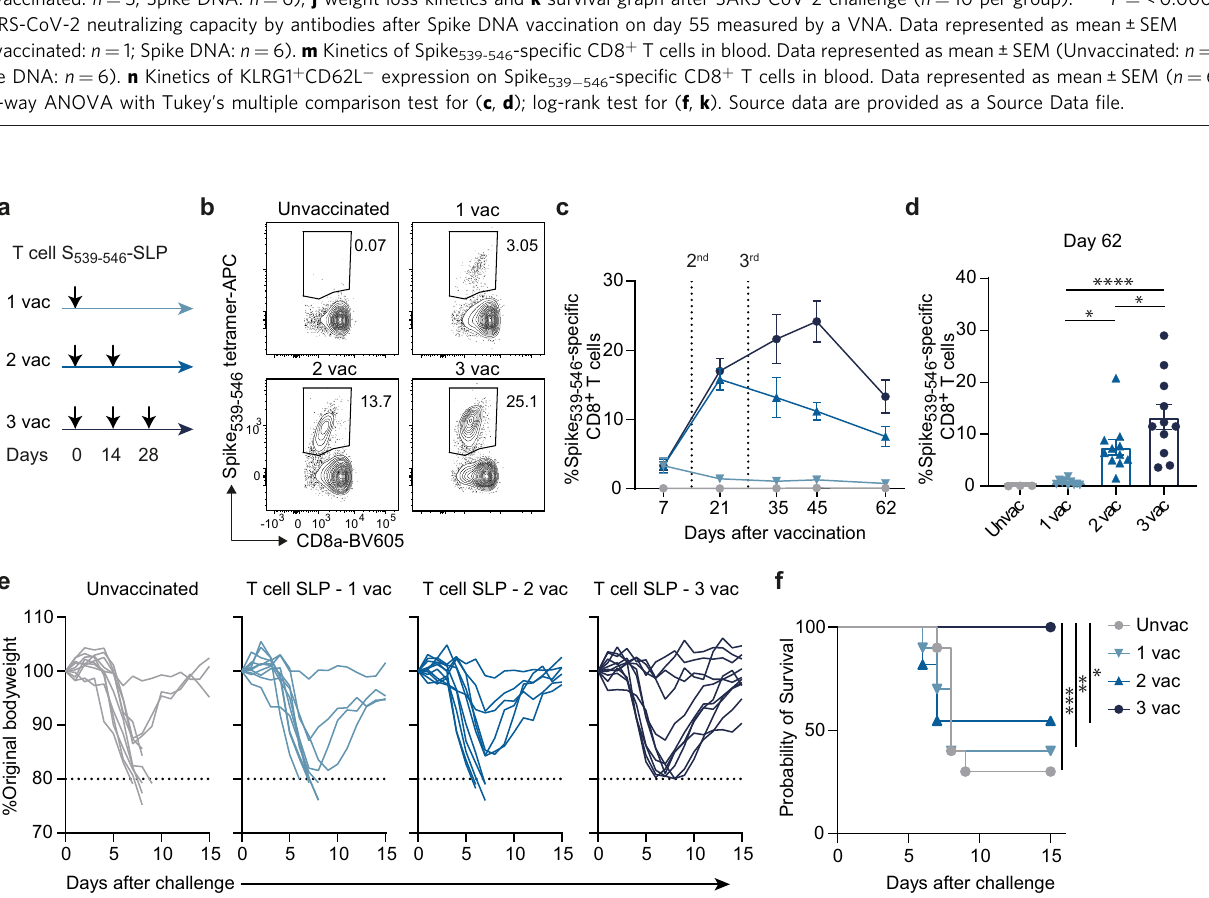
Fig. 2 A third vaccination with a single T cell epitope protects against SARS-CoV-2 challenge. a K18-hACE2 transgenic mice were vaccinated subcutaneously on day 0 (1 st vaccination), day 14 (2 nd vaccination), and day 28 (3 rd vaccination) with the Spike 539-546 -SLP vaccine adjuvanted with CpG. The Spike 539-546 -speci fi c CD8 + T cell response was determined in blood in time. Five weeks after the fi nal vaccination, vaccinated and unvaccinated mice were intranasally infected with 5000 PFU of SARS-CoV-2, and monitored for weight loss and signs of clinical discomfort. b Representative fl ow cytometry plots of Spike 539-546 -speci fi c CD8 + T cells determined in the blood circulation at day 45 by MHC class I tetramer staining. c Spike 539-546 -speci fi c CD8 + T cell kinetics in blood at indicated days after vaccination. Data is represented as mean ± SEM (Unvaccinated: n = 3; 1 vac: n = 10; 2 vac, 3 vac: n = 11). d Spike 539-546 -speci fi c CD8 + T cells in blood at day 62 after vaccination. Data represented as mean ± SEM (Unvaccinated: n = 3; 1 vac: n = 10; 2 vac, 3 vac: n = 11). Symbols represent individual mice. * P = 0.022-0.047, **** P = < 0.0001. e Weight loss kinetics in time of SARS-CoV-2 challenged K18-hACE2 transgenic mice after T cell epitope SLP vaccination. f Survival graph of SARS-CoV-2 challenged K18-hACE2 transgenic mice after T cell epitope SLP vaccination (Unvaccinated, 1 vac: n = 10; 2 vac, 3 vac: n = 11). * P = 0.0131, P = **0.0029, *** P = 0.0008. One-way ANOVA with Tukey ’ s multiple comparison test for ( d ); log-rank test for ( f ). Source data are provided as a Source Data fi